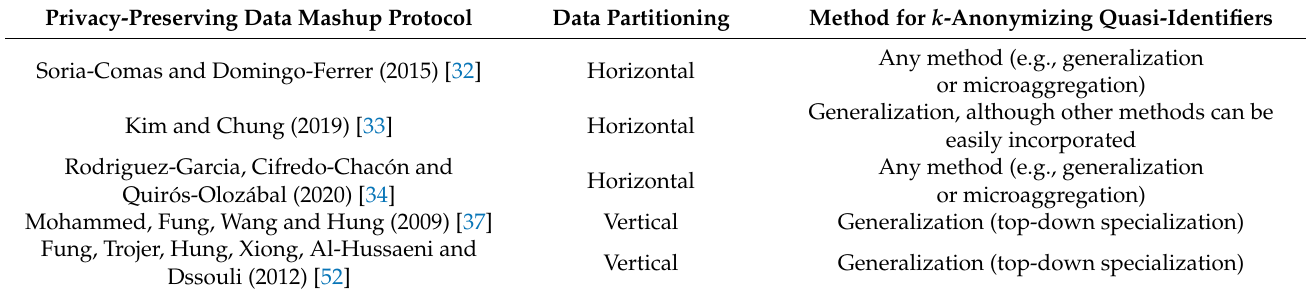
Table 1. Comparison of privacy-preserving data mashup protocols that yield k -anonymized raw data. Privacy-Preserving Data Mashup Protocol Data Partitioning Method for k -Anonymizing Quasi-Identifiers Any method (e.g., generalization Soria-Comas and Domingo-Ferrer (2015) [32] Horizontal or microaggregation) Generalization, although other methods can be Kim and Chung (2019) [33] Horizontal easily incorporated Any method (e.g., generalization Horizontal or microaggregation) Vertical Generalization (top-down specialization) Vertical Generalization (top-down